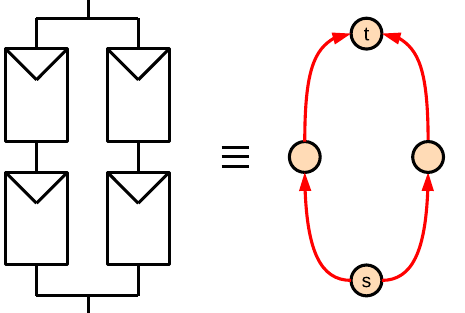
Figure 3. Example of a PV panel structure and its associated array-digraph.